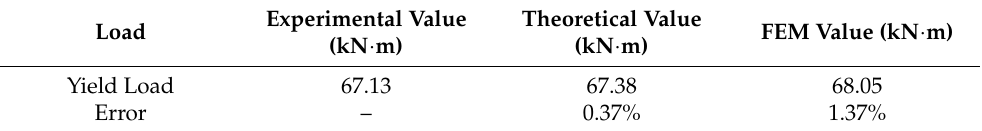
Table 5. Yield load of the hollow structure.